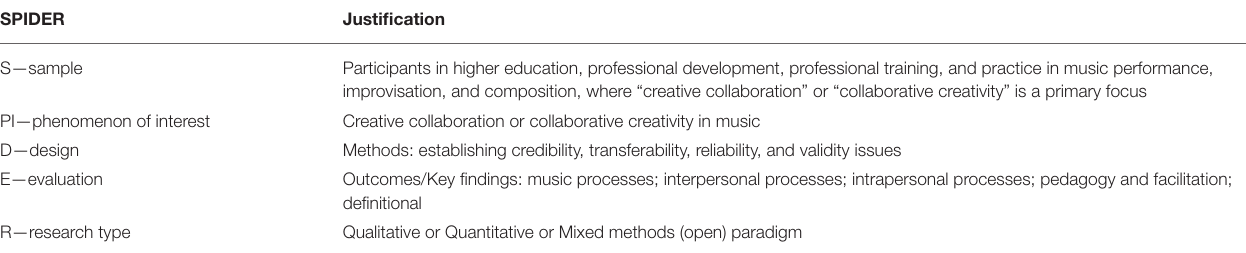
TABLE 2 | SPIDER tool [adapted from Cooke et al. (2012) to the study’s context]. SPIDER